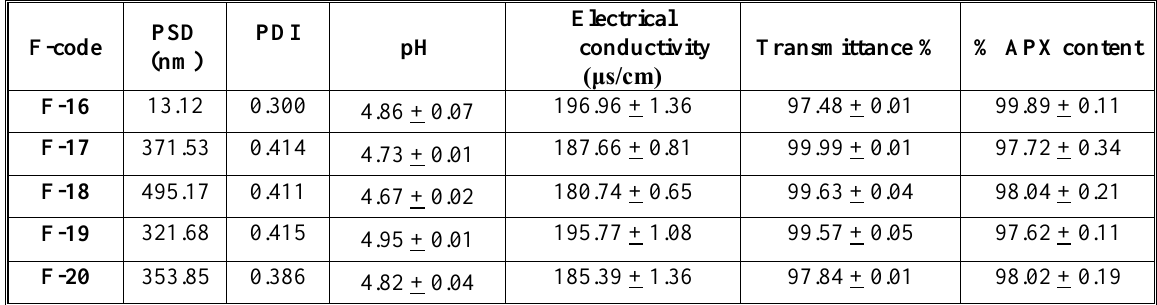
Table 2. Continued results of PSD, PDI, pH, electrical conductivity, T%, APX content%, for the prepared APX- NE formulations, (mean ± SD, n = 3).